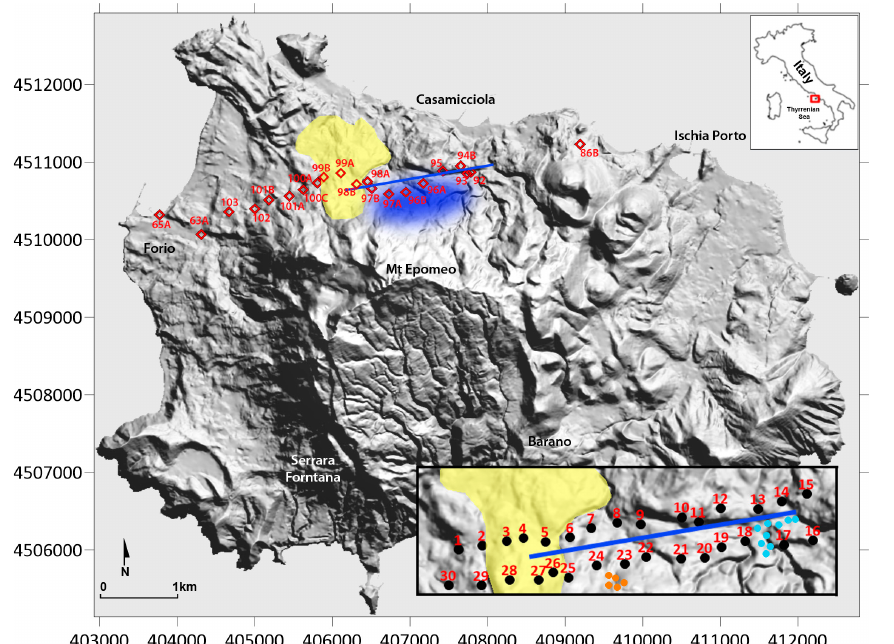
Figure 1. Digital Terrain Model (source INGV Laboratorio Geomatica) of Ischia Island with indication of: (i) surface fault trace [adapted with permission from [25] (blue line); (ii) levelling benchmarks (red diamonds); (iii) area covered by the 1883 Casamicciola landslide (yellow area); area of maximum coseismic displacement (subsidence) for the 2017 earthquake inferred from DInSAR data [25] (blue area). Inset: couples of points (15; 1 to 30 black points), located along the two sides of the fault, facing each other at distance of ~250 m, for which is calculated the differential vertical displacement for the period January 2015–December 2019. In the inset, fumaroles of Mt. Cito (orange points) and hot thermal springs of Bagni area (blue points) are also shown.